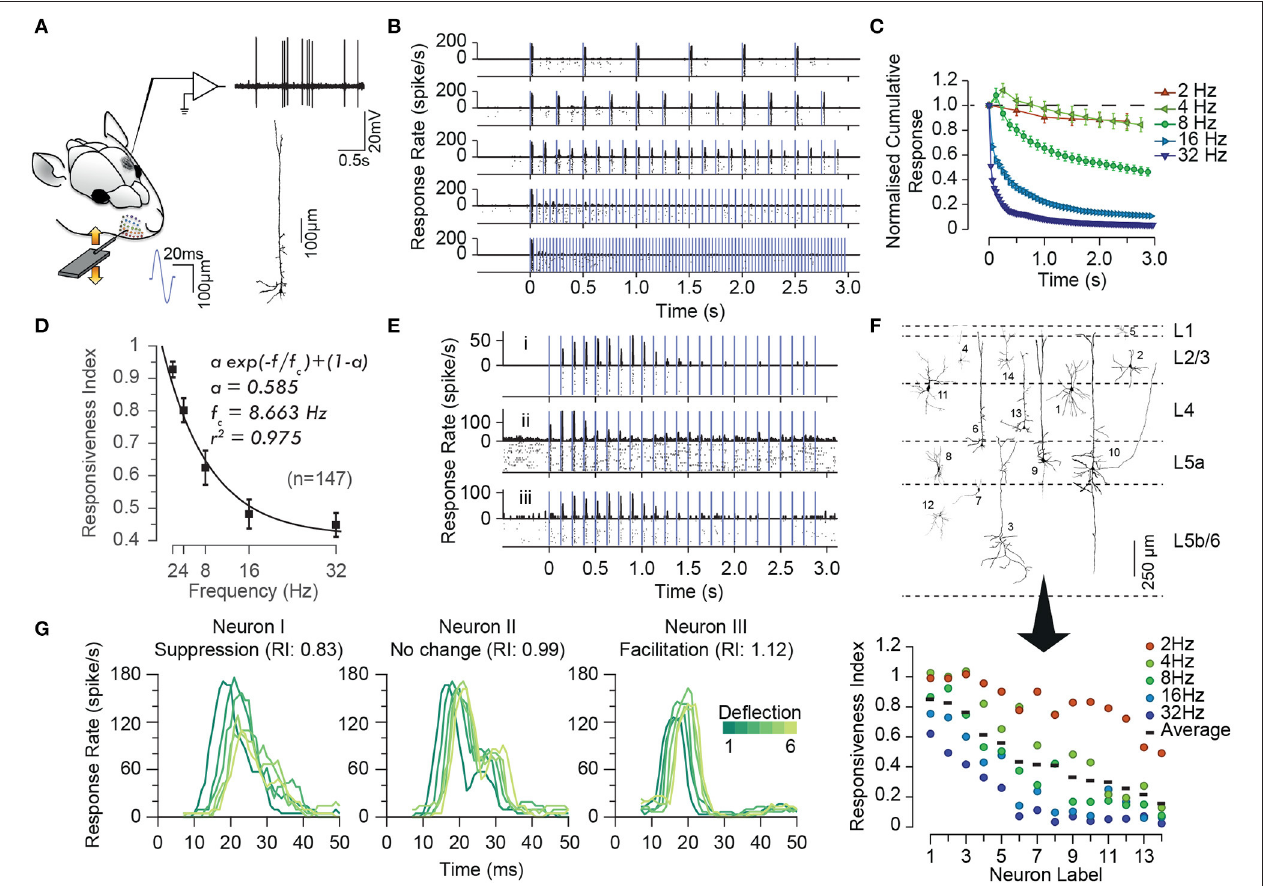
FIGURE 1 | Characterisation of the adaptation profile to repetitive stimulation. (A) Histological reconstruction of a sample layer 5 pyramidal neuron juxta-cellularly recorded from the vibrissal area of S1 in anaesthetised rats while applying deflections (200 µm in amplitude) to the principal whisker. (B) Raster plots and peri-stimulus time histograms (PSTHs) for the sample neuron in (A) for different stimulation frequencies. Vertical purple lines indicate individual deflections. Dots in the lower parts of panels indicate individual spikes and rows correspond to trials. (C) The cumulative response of the sample neuron as a function of time normalised to the response to the first deflection exhibiting a systematic decrease in responsiveness with time. The decline is steeper and reaches a lower level as the stimulation frequency increased. Error bars indicate standard error of the means (s.e.m.) across trials. (D) On average, across neurons, adaptation increases with stimulation frequency in an exponential manner (solid curve). Responsiveness index (RI) is defined as the net neuronal response rate to the 3-s train of deflections divided by the response to the first deflection. Error bars indicate s.e.m. (E) Prominent response facilitation in a subset of neurons. The response profile of three sample neurons exhibiting response facilitation is shown at stimulation frequency of 8 Hz. (F) Neuronal reconstruction and diversity of adaptation. Upper panel illustrates the morphology of 14 example reconstructed neurons and their cortical location as identified by histology. The lower panel shows the diversity of adaptation for the 14 neurons. (G) Response latencies increases over the time course of stimulation, irrespective of the dynamics of their response rate (facilitation versus adaptation). PSTHs for 3 sample neurons to 6 consecutive deflections at 2 Hz stimulation. Different shades of green represent the order of deflection within the simulation train, with darker corresponding to earlier deflections. Modified from Kheradpezhouh et al.